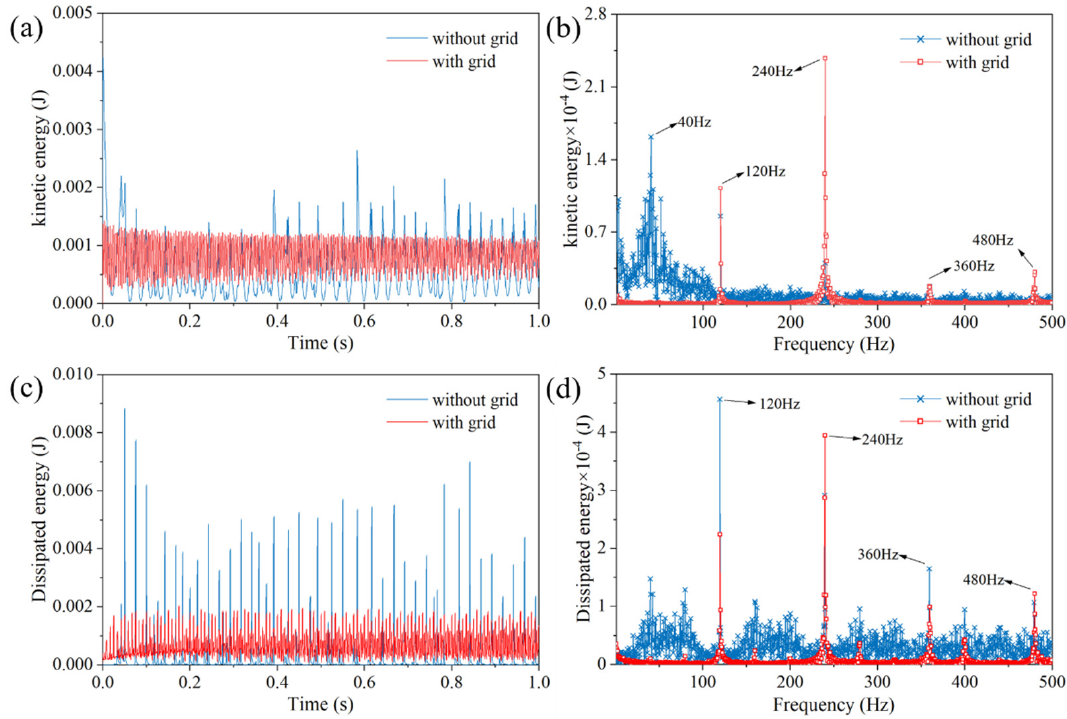
Figure 12. ( a ) Time domain diagram of particle damping kinetic energy; ( b ) spectrum of particle damping kinetic energy; ( c ) time domain diagram of particle damping dissipation energy; ( d ) spectrum of particle damping dissipation energy.